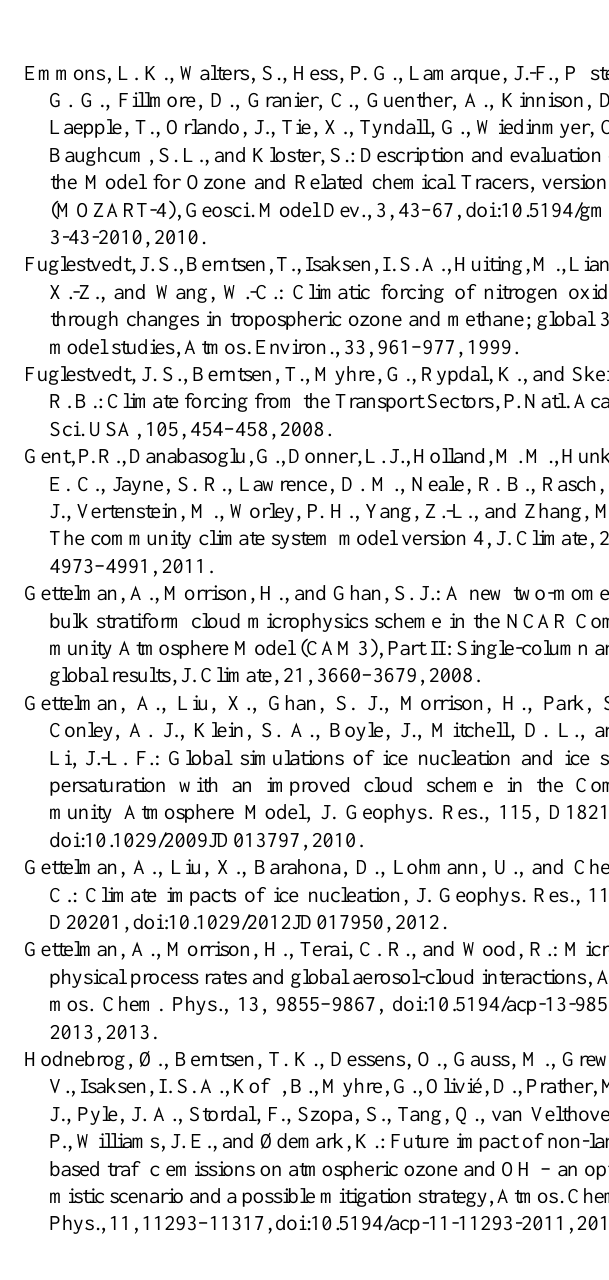
Figure 11. Yearly mean radiative forcing (mWm − 2 ) from O 3 due to aviation NO x emissions. CAM5 is on the left, CAM4 is on the